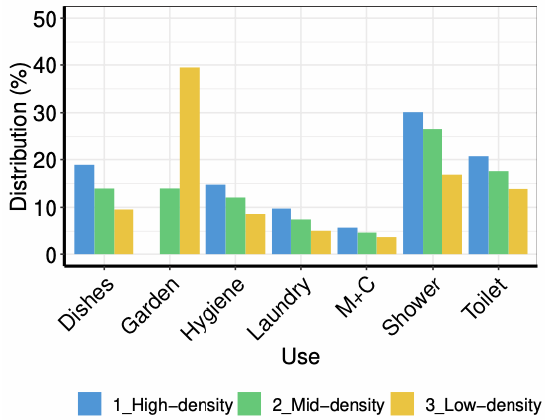
Figure 2. Simulated average water use for each domestic use depending on the housing type. The distribution of indoor and outdoor uses shows significant differences between the three housing types .